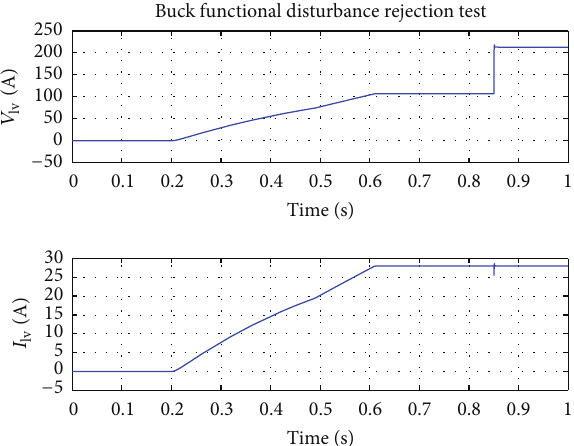
Figure 15: Boost mode test for functional robustness